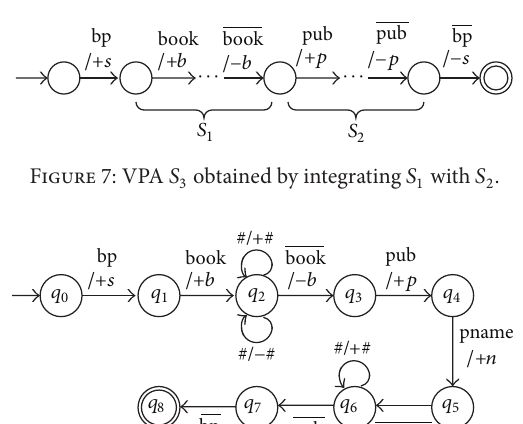
Figure 5: VPA 𝑆 1 expressing the XML document (information about books).